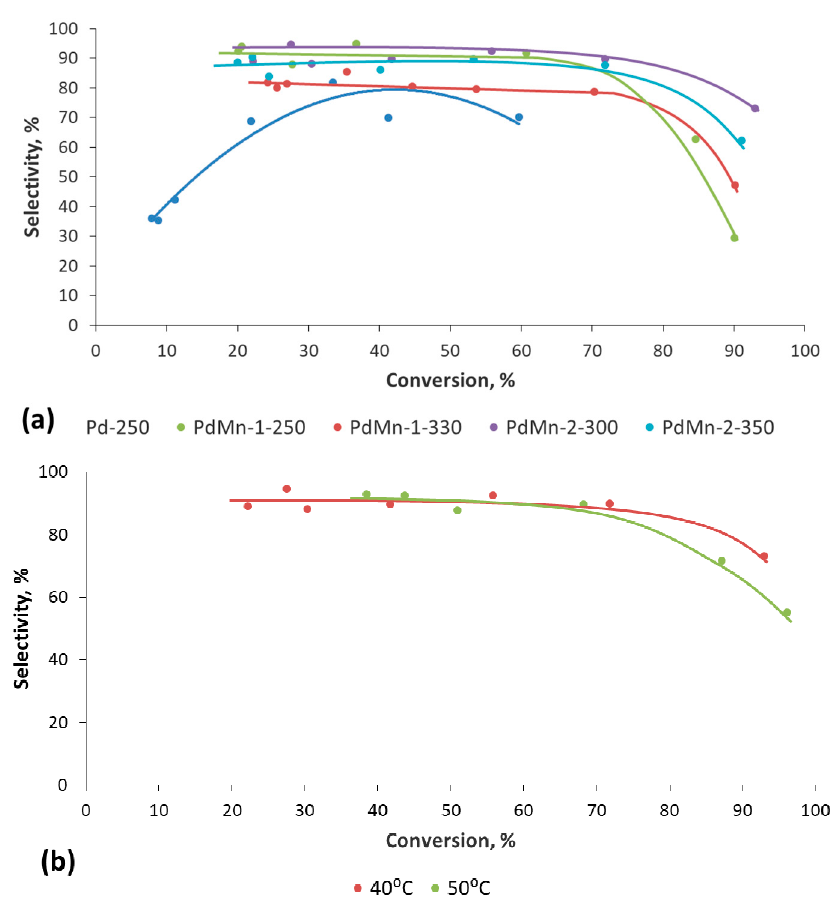
Figure 7. Ethylene selectivity vs. conversion at 40 °C for alumina-supported Pd-Mn catalysts: ( a ) effect of treatment temperature and Mn content; ( b ) PdMn-2-300 at 40 and 50 °C.